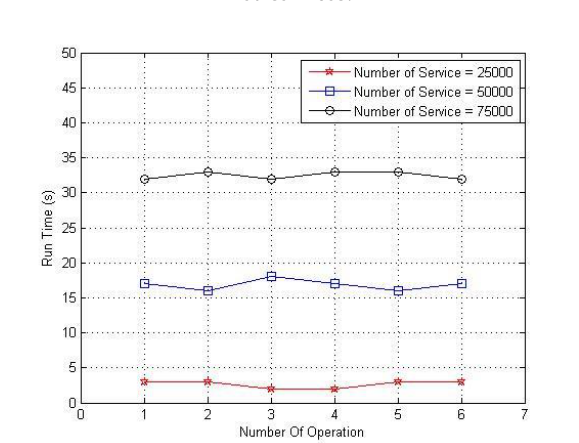
Figure 3. Runtime of proposed algorithm for the number of steps